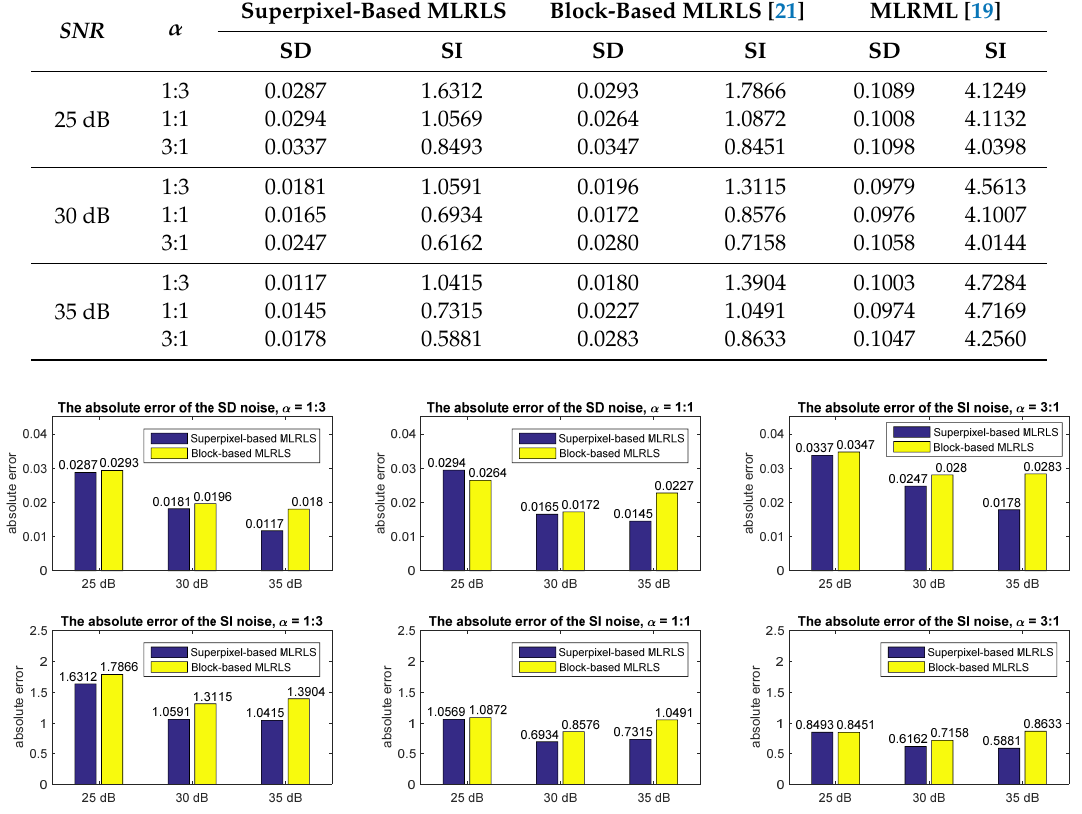
Figure 8. The optimal absolute errors of the SD noise, the SI noise and the overall optimization.